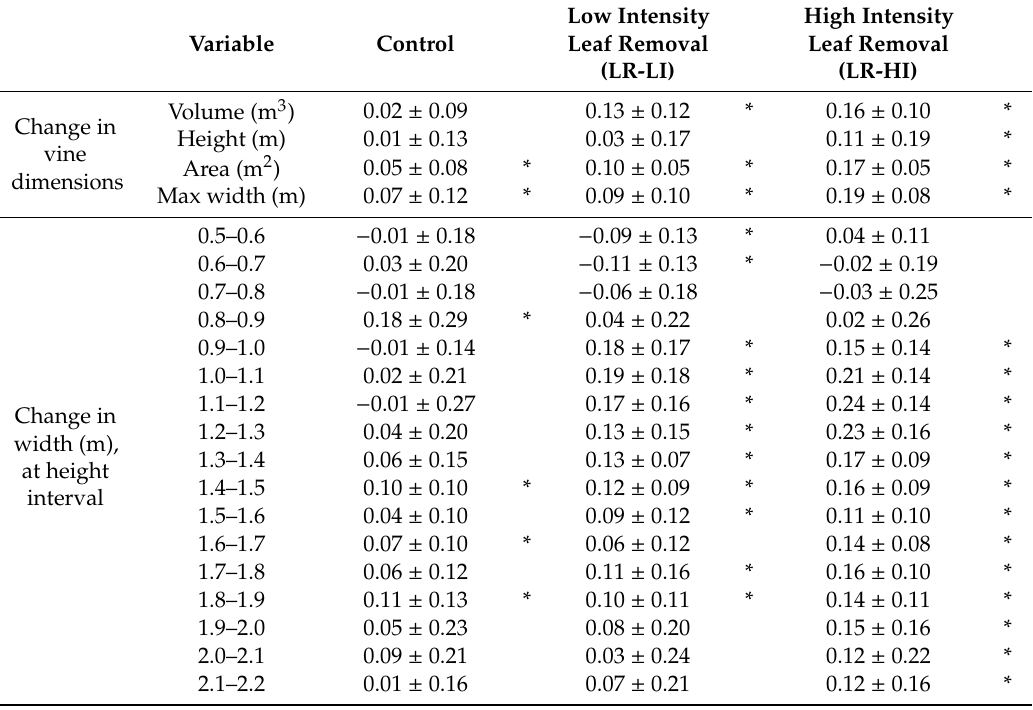
Table 5. Mean and standard deviation of vine dimension changes after low and high intensity leaf removal experiment at Ausejo-1. The table is divided in two parts: (1) changes in main dimensions of the vine, (2) changes in the width at di ff erent height intervals. Values followed by an asterisk are indicative of significant di ff erences among the vine dimensions before and after the canopy management (paired T -test at p =